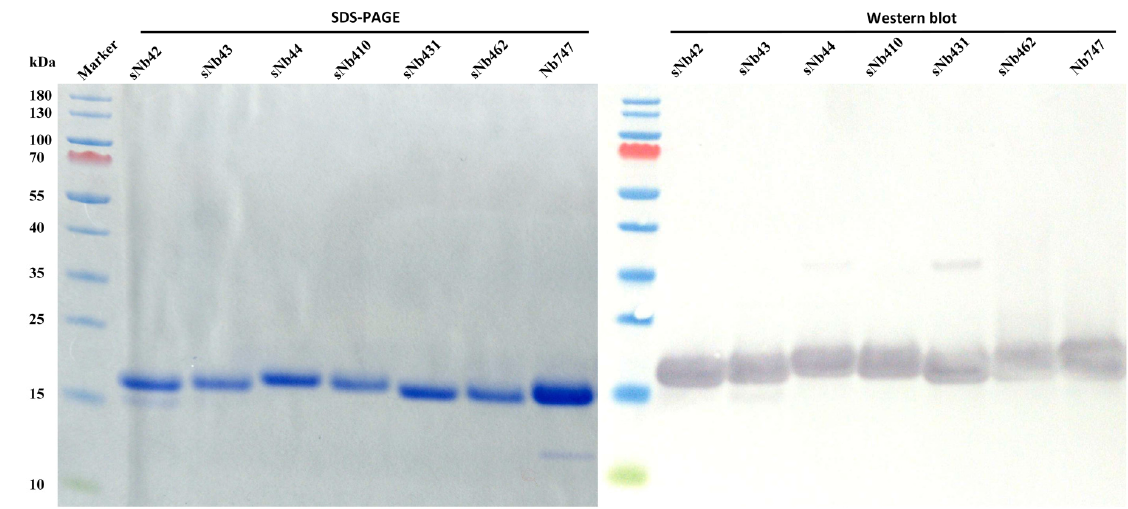
Figure 2. Confirmation of the specific Nbs. SDS-PAGE and Western blot of the His- and HA-tagged Nbs after expression and purification by IMAC and SEC.